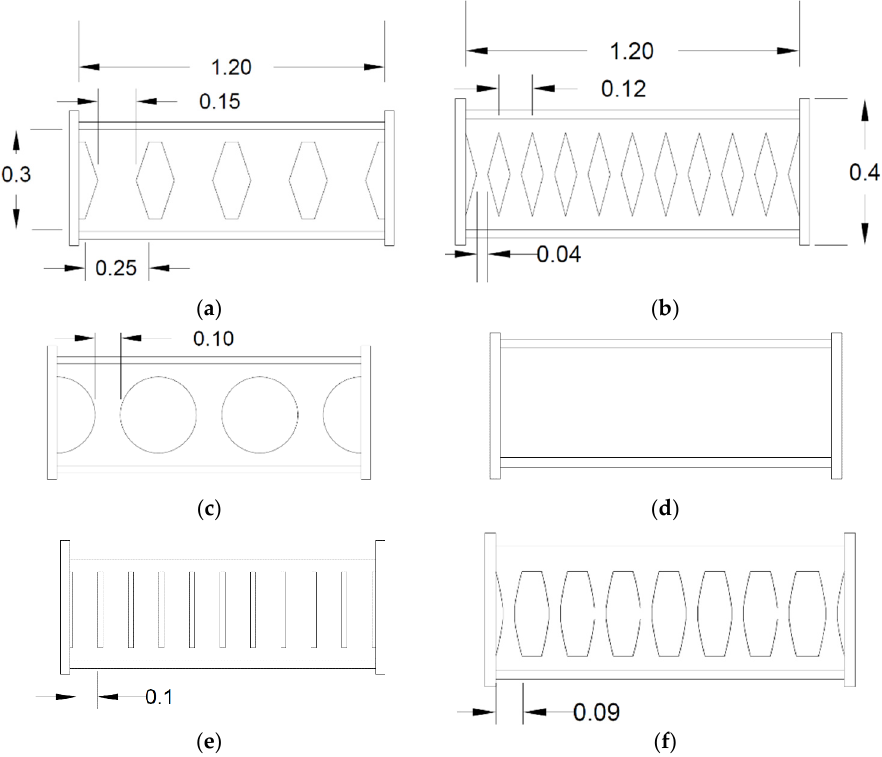
Figure 9. The designed models for EBF system ( a ) FBF ( b ) SBF ( c ) Circle ( d ) Solid ( e ) Straight ( f ) Oval. ( a ) t = 2.2 mm. ( b ) t = 2.2 mm. ( c ) t = 2.2 mm. ( d ) t = 0.8 mm. ( e ) t = 3.0 mm. ( f ) t = 2.5 mm.